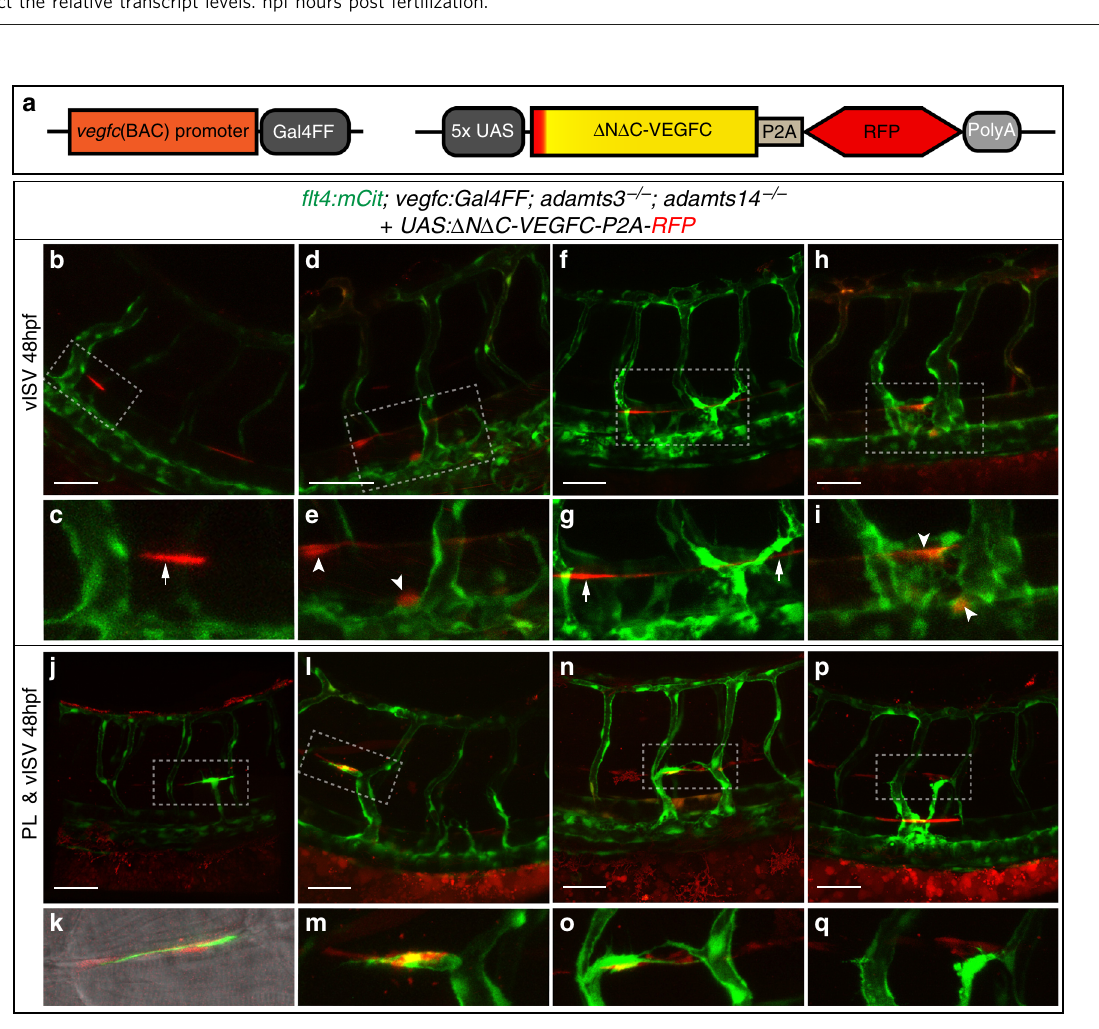
Fig. 10 Local Vegfc processing at the HM is required to guide endothelial cells to this region. a Schematic depiction of the mature human VEGFC overexpression construct and the vegfc:Gal4FF transgenic line, which was used to drive mosaic expression of the construct upon transient injection. b – q vegfc: Gal4FF positive embryos were injected with the overexpression construct at the one-cell stage and imaged at 48hpf. All embryos shown are adamts3; adamts14 double mutant, transgenic for fl t4:mCitrine (green) and express UAS: Δ N Δ C-VEGFC-P2A-RFP (red). b , c Expression of UAS: Δ N Δ C-VEGFC-P2A-RFP in hypochord cells (white arrow) rescues vein formation. d , e Local vISV rescue upon expression of mature VEGFC in DA cells (white arrowhead). f – i Venous hyper-sprouting with ectopic venous structures formed in the vicinity of hypochord cells ( f , g , arrows) or DA cells ( h , i , arrowheads) with expression of the Δ N Δ C-VEGFC construct. j , k UAS: Δ N Δ C-VEGFC-P2A-RFP positive fi broblasts recruit PL cells to the HM region. l , m Expression of mature VEGFC in hypochord cells and in fi broblasts at the HM rescues vISV and PL formation in adamts3; adamts14 double mutant embryos. Note the close proximity of the PL cell to the Δ N Δ C-VEGFC producing fi broblasts. n , o Combined expression of mature VEGFC in DA cells and fi broblasts at the HM results in the formation of vISV and PL cells close by. p , q Simultaneous expression of Δ N Δ C-VEGFC in hypochord cells and in fi broblasts at the HM results in a local rescue of PL and vISV formation but can additionally lead to a hyper-branching of venous structures at the level of the DA. c , e , g , i , k , m , o , q : Zoom-in image of the indicated regions in b , d , f , h , j , l , n , p . Scale bars: 50 µ m. DA dorsal aorta, HM horizontal myoseptum, hpf hours post fertilization, PL parachordal lymphangioblast, vISV venous intersegmental